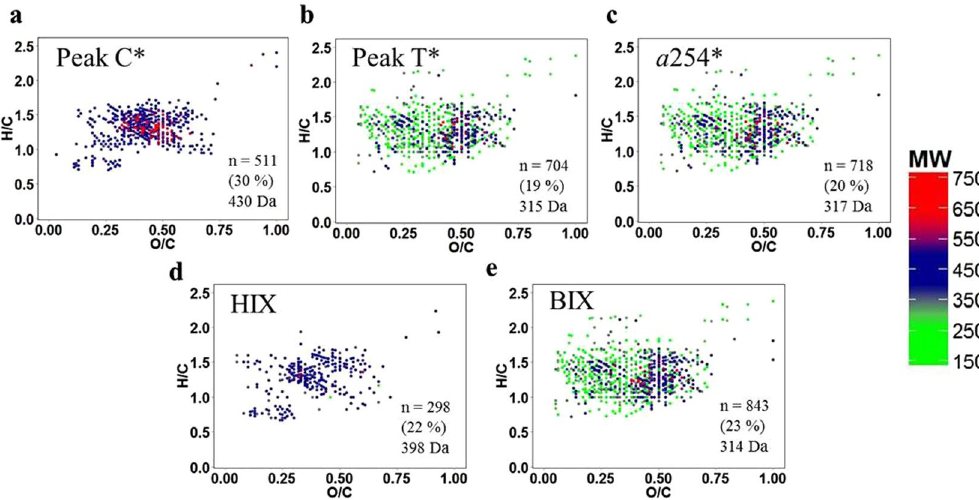
Figure 3. Van Krevelen diagrams. Molecular formulae positively correlated with ( a ) peak C * , ( b ) peak T * , ( c ) a254 * , ( d ) HIX and ( e ) BIX. Color scale represents the molecular weight. In the right-bottom corner of each panel is summarized the number of molecular formulae correlating, the percentage of peak intensity and the average molecular weight. Figure created using R software (version 3.1.1, 2014-07-10, http://cran.r-project.